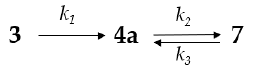
Figure 5. Interconversion kinetics for compounds 3 , 4a, and 7; each compound is represented by a fitted curve based on integral values of its two imidazole signals.